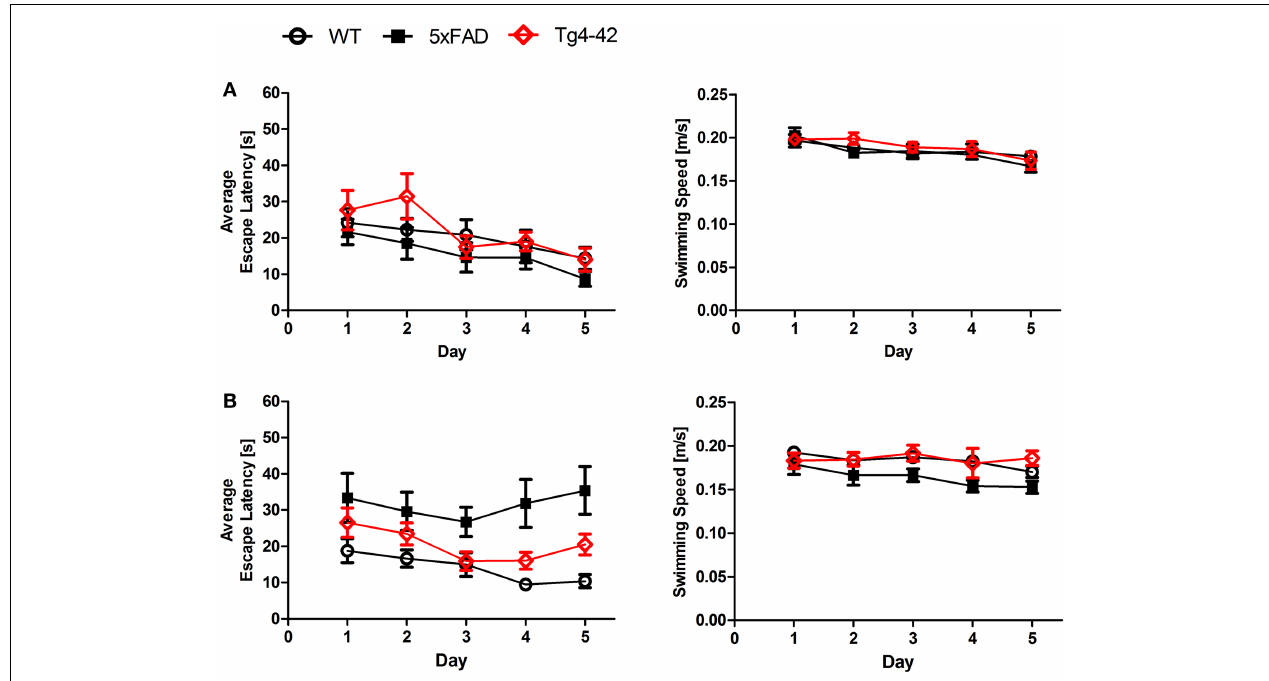
regardless of the genotype. Furthermore, agedWT mice (B) showed a progressive improvement in the escape latency over time.The escape latencies for agedTg4–42 and 5XFAD did not improve over the 5days of training. Swimming speed was not affected in all mice tested. Escape latency and swimming speed: repeated measures ANOVA followed by Bonferroni multiple comparisons. m age in